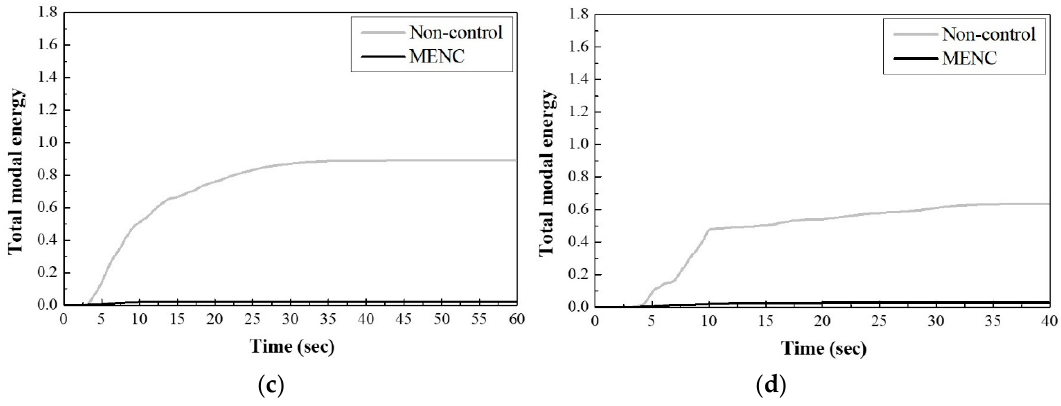
Figure 12. Comparison of total modal energy in the control and non-control of the building structure under the seismic load: ( a ) Landers earthquake; ( b ) Cape earthquake; ( c ) San Simeon earthquake; ( d ) Loma Prieta earthquake.